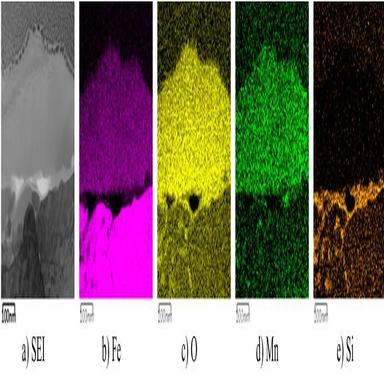
TEM EDS elemental mapping of the oxidized sample. a) SEI, b) Fe, c) O, d) Mn, e) Si.